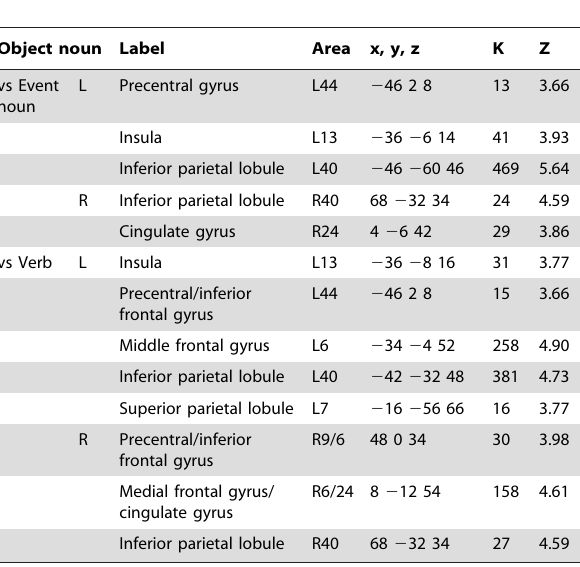
Table 1. Activations of object noun versus event noun, and versus